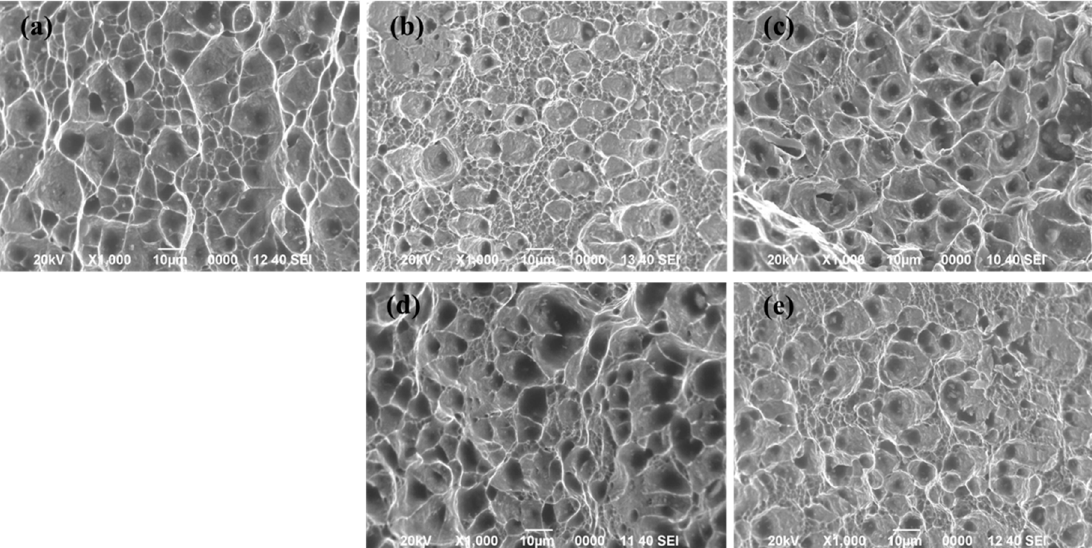
Figure 12. SEM observations of the tensile test fractures of 253 MA ASS after ( a ) cold rolling and ( b ) annealing at 1100 °C with annealing times of ( c ) 900; ( d ) 1800; ( e ) 3600 s.